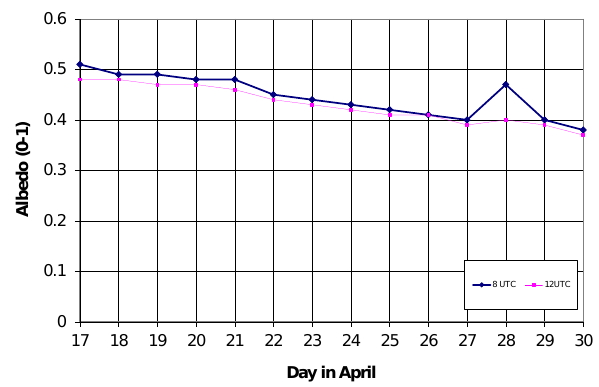
Fig. 6. The broadband VIS albedo of snow measured with CM4 at SNORTEX sites of (a) Kommattivaara (a lightly forested hill) dur- ing 20 April, (b) Mantovaaranaapa (a completely open aapa mire) during 22 April, and (c) Korppiaapa (also a completely open aapa mire) during 23 April.